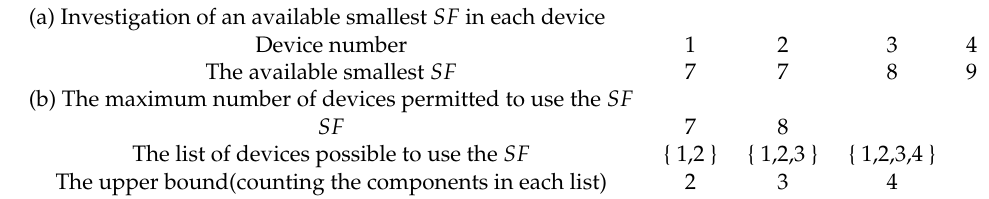
Table 2. An example of how to set the upper bound of the number of devices which use a specific SF .